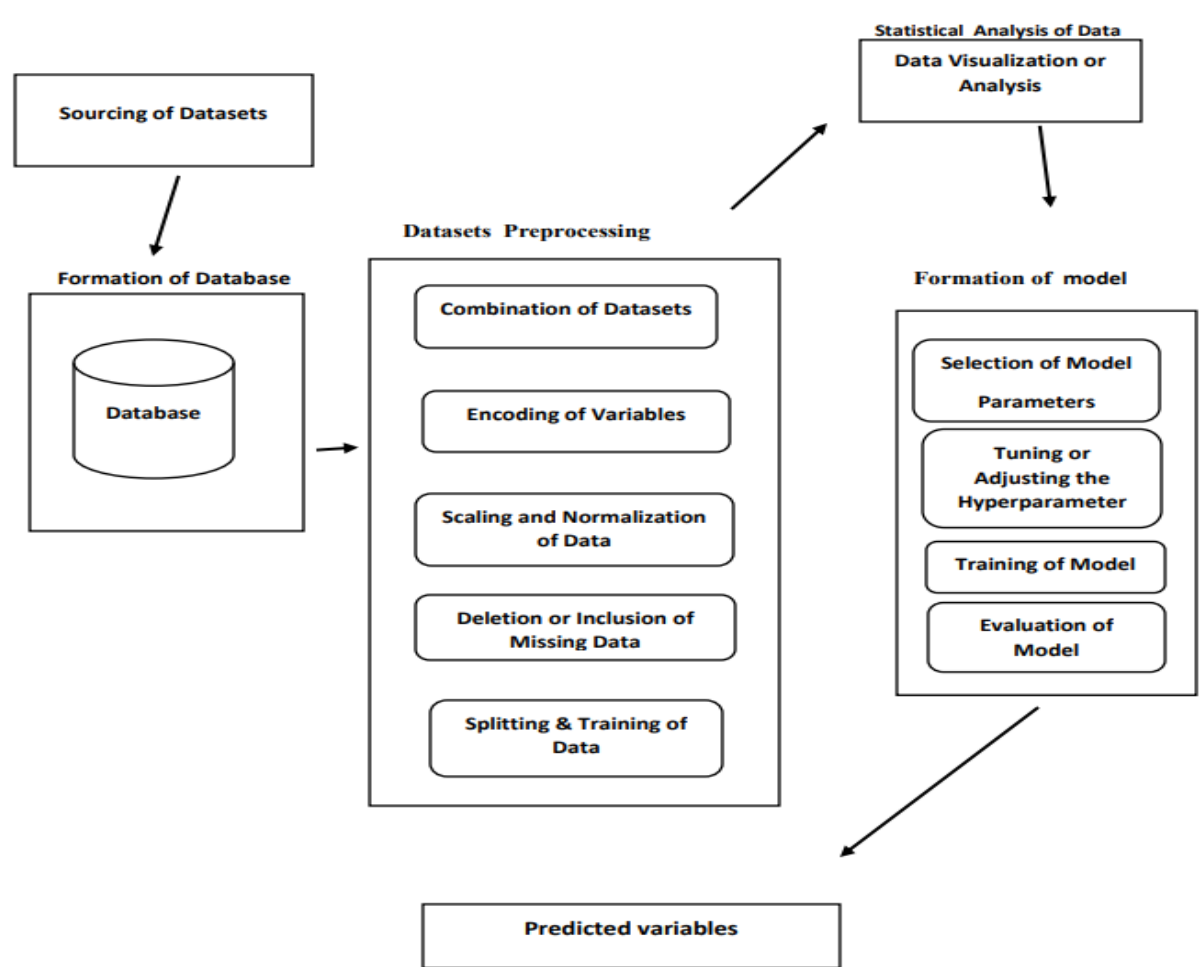
Figure 2. Process flow for the parametric predictions.